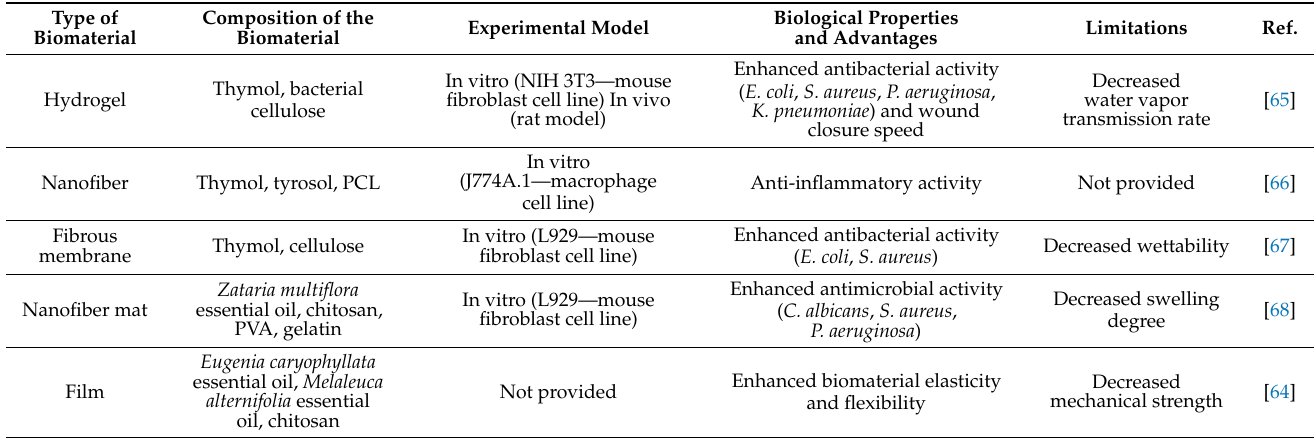
Table 2. Essential-oil-loaded biomaterials for wound healing